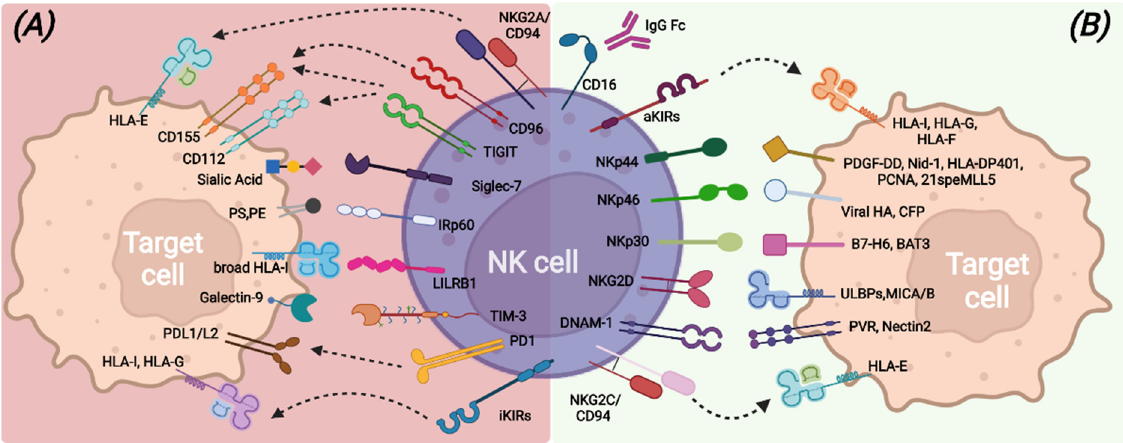
Figure 1. Main inhibitory ( A ) and activating ( B ) NK-cell surface receptors and their cognate ligands on target cells.